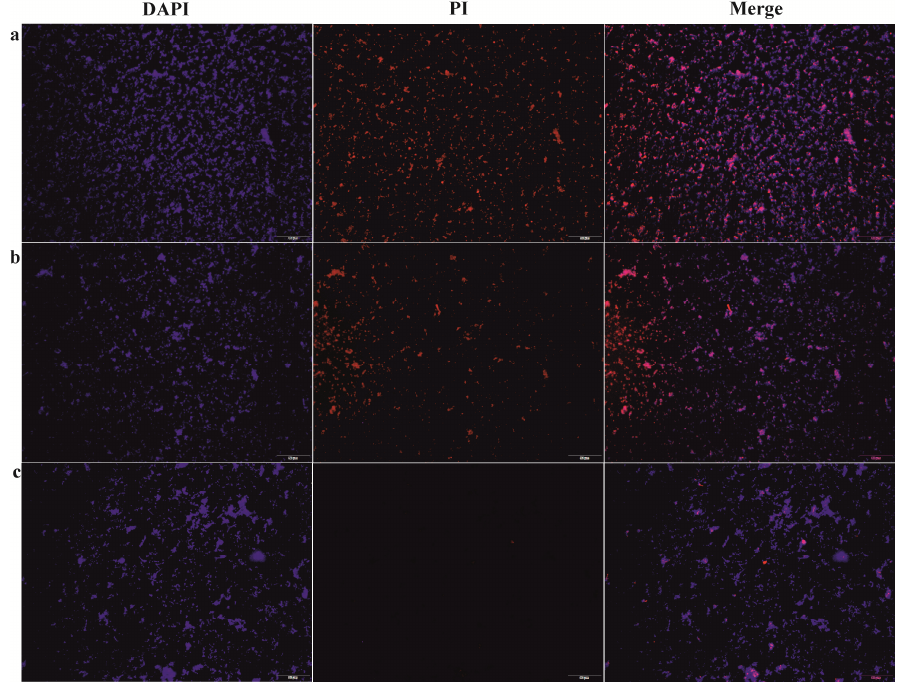
Figure 2. Live/dead viability assay. DAPI/PI staining of F. novicida treated with ( a ): 5% D1, ( b ): 1% D2, ( c ): 0.2% D3 for 5 min. Bacterial suspensions (100 µL) (OD = 1) were treated with 100 µL of different ( c ): 0.2% D3 for 5 min. Bacterial suspensions (100 µ L) (OD = 1) were treated with 100 µ L of di ff erent disinfectants, incubated at room temperature for 5 min and stained with PI and DAPI. The images were taken on a fluorescence microscope. Ten fields for each sample were randomly